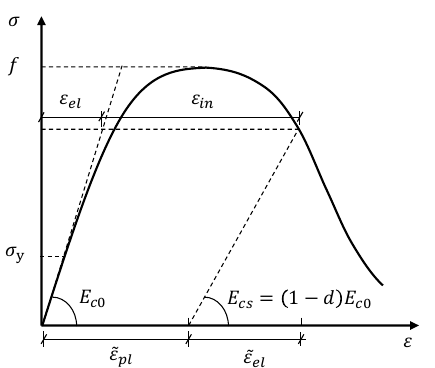
Figure 5. Damage evolution and degradation of the material stiffness beyond the peak stress of concrete.